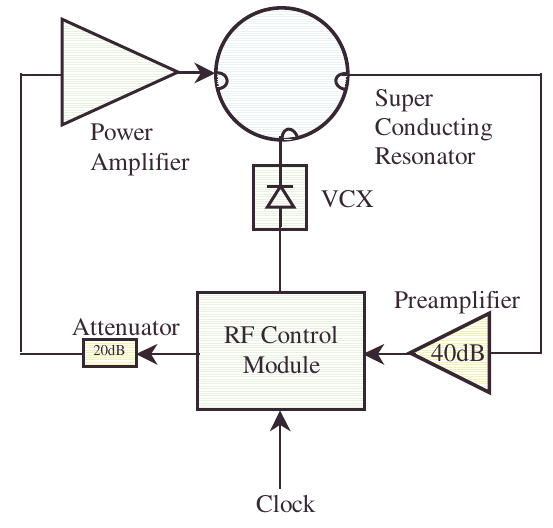
FIG. 4. (Color) SCR low field operation simplified diagram.